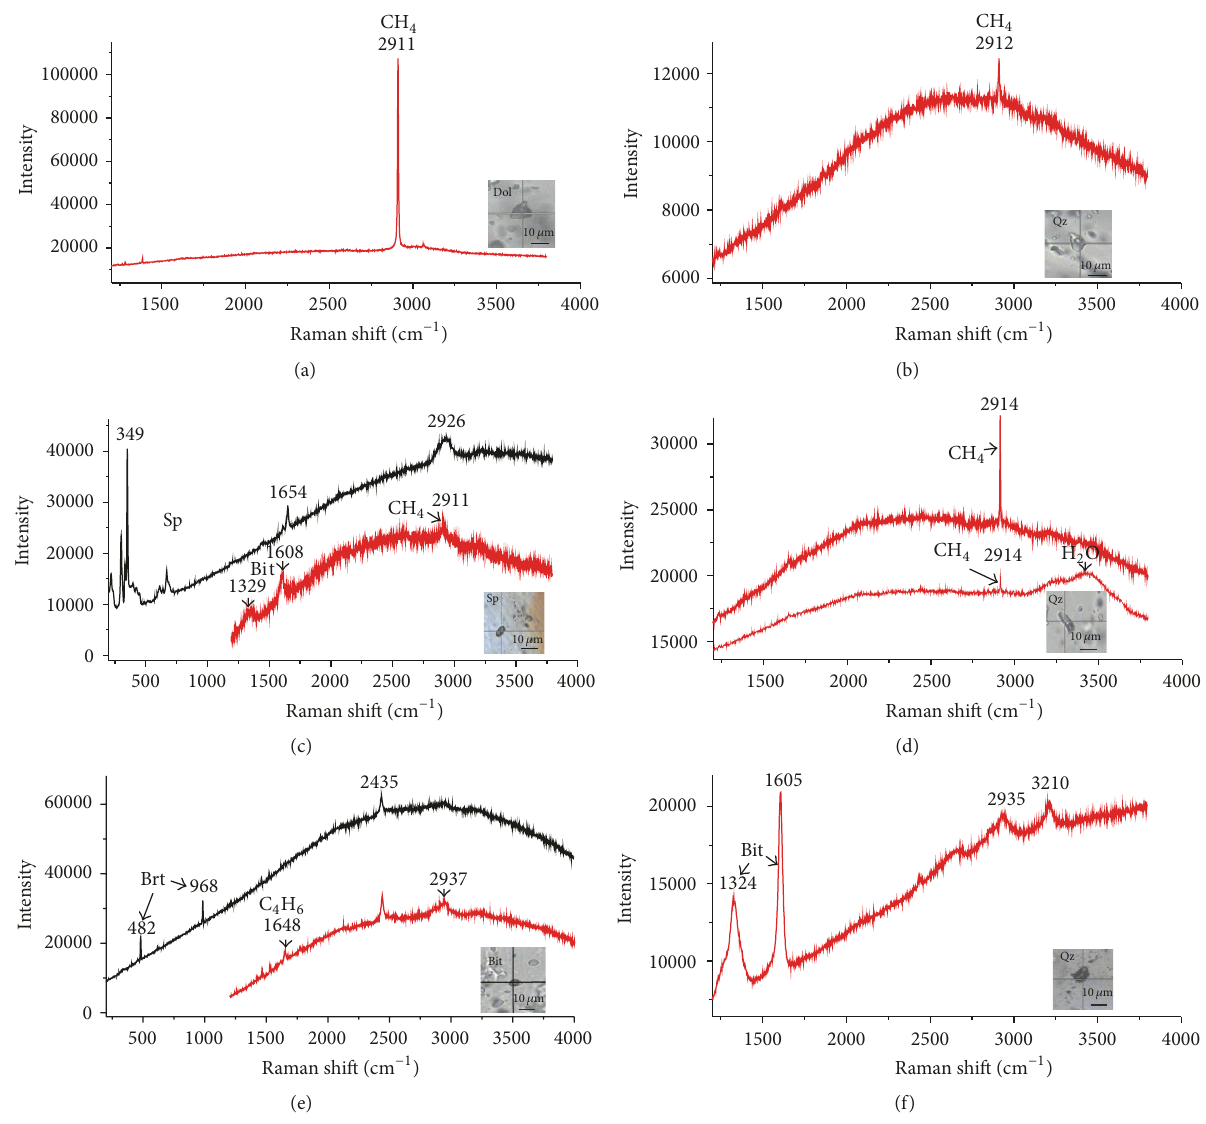
Figure 8: Representative Raman spectra of hydrocarbon-bearing inclusions for the Nanmushu Zn-Pb deposit. Black line stands for the Raman spectra of hosted minerals, while the red line represents the Raman spectra for FIs. (a) CH 4 -rich inclusions in dolomite from stage I. (b) CH 4 -rich inclusions in quartz from stage I. (c) Hydrocarbon-bearing inclusions in sphalerite from stage II, with CH 4 and bitumen in the carbonic phase. (d) Hydrocarbon-bearing inclusions in quartz from stage III shows their vapor phase is composed of CH 4 with their liquid phase containing H 2 O and CH 4 . (e) Hydrocarbon-bearing inclusions in barite from stage III, with C 4 H 6 and bitumen in the carbonic phase. (f) Hydrocarbon-bearing inclusions in quartz from stage III, with bitumen in the carbonic phase. Brt, barite; Dol, dolomite; Qz, quartz; Sp,